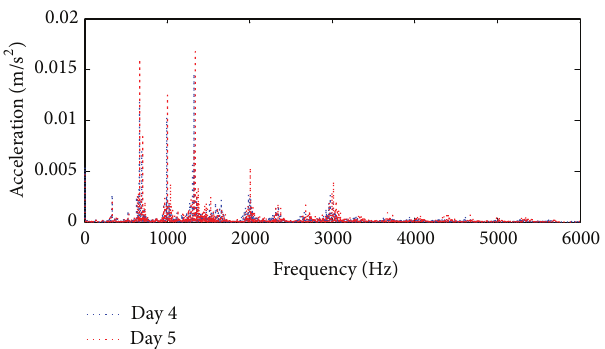
Figure 20: Spectrum of the experimental signal.